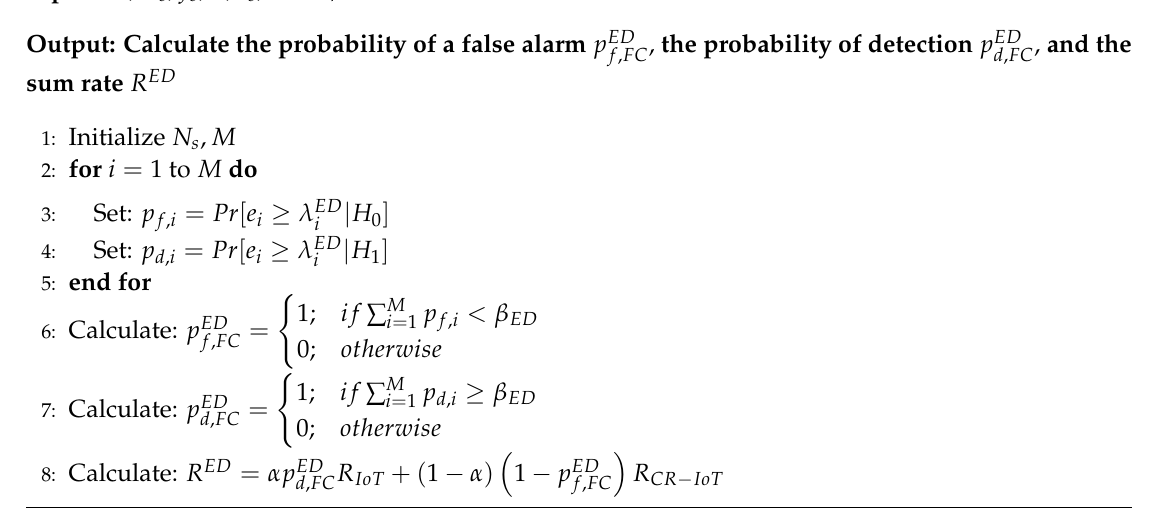
Algorithm 1 The conventional ED technique with cooperation for a CR-IoT network